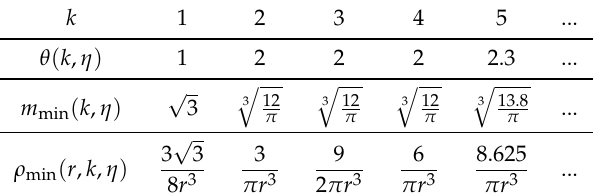
Table 4. The minimum m and corresponding volume density to ensure an 89% k -coverage.